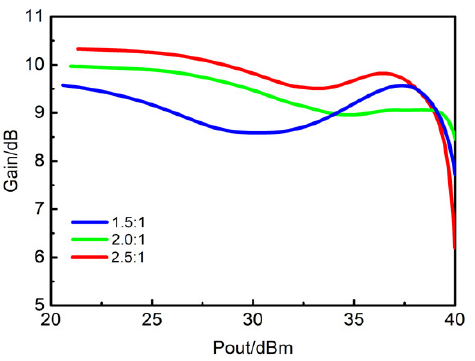
Figure 3. Gain comparison of power dividers with different power ratios.